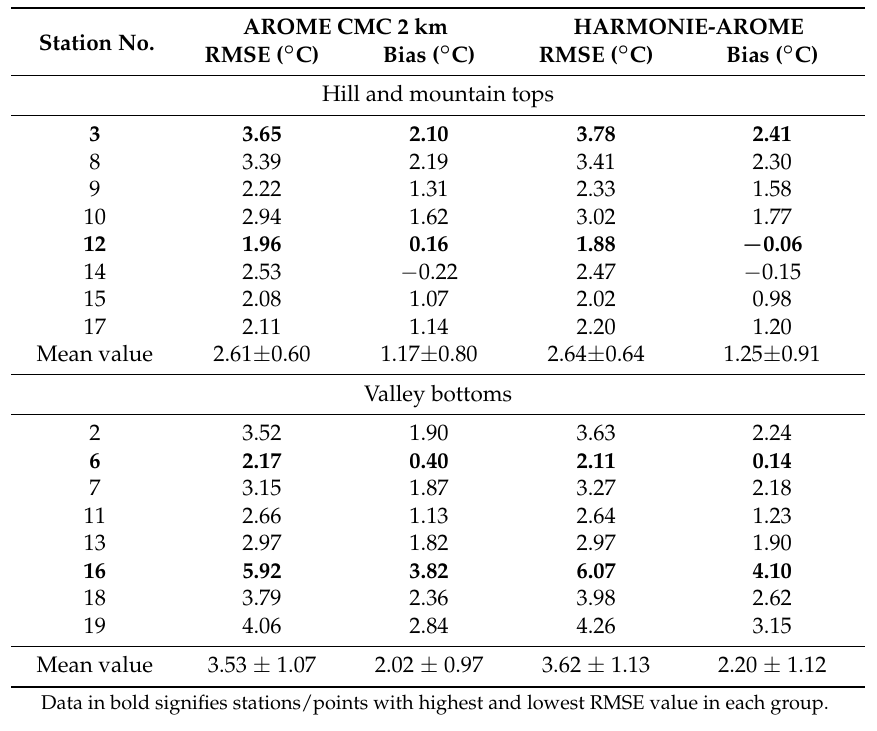
Table 10. Comparison of observations with HARMONIE-AROME model and AROME CMC 2 km operational model.